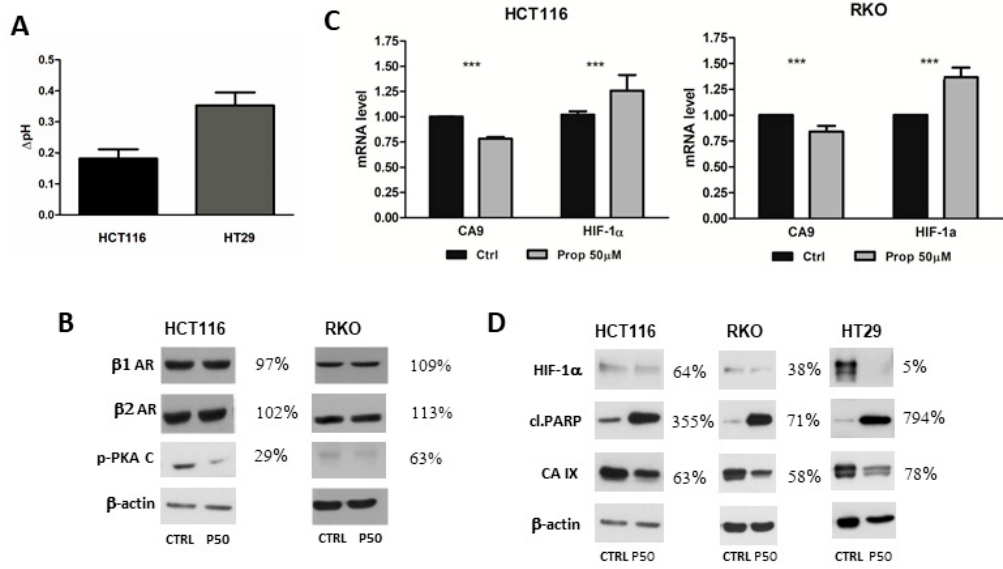
Figure 2. Expression of β 1 and β 2-AR after beta-blockade by propranolol. ( A ) Propranolol mediated alkalization of extracellular pH in hypoxia. Colorectal cancer cells HCT116 and HT29 were treated with propranolol under hypoxic conditions for 24 h. Graph shows a difference between pH of propranolol treated samples and pH of appropriate controls (mean±standard deviation, n = 3) ( B ) Western blot analysis of β 1 and β 2-AR levels in HCT116 and RKO cells. No significant differences in the levels of β 1 and β 2 receptors were detected. Beta-blockade by propranolol decreased level of phosphorylated form of catalytic subunit of PKA under hypoxic conditions. ( C ) Graph of the results of quantitative PCR (qPCR) analyses. HCT116 and RKO cells were cultured in hypoxic conditions for 24 h. The expression of CA9 decreased after propranolol treatment. The mRNA level of HIF1 α increased. The graph shows changes in mRNA levels normalized to actin. The results (mean ± stdev) represent the mean from three independent biological experiments, all performed in triplicates. Statistical significance was analyzed using the Student’s t -test and expressed as a p -value (*** p < 0.001) ( D ) Immunoblotting of CA IX and HIF1 α proteins after treatment of colorectal cancer cell lines RKO, HCT116 and HT29 with propranolol under hypoxic conditions. Levels of CA IX and HIF1 α in hypoxia decreased after beta-blockade in all three analysed cell lines and level of cleaved PARP increased. % values describe a difference in the signal of propranolol treated samples in comparison to the controls which were set as 100%. P50 represents propranolol at the concentration 50 µM.